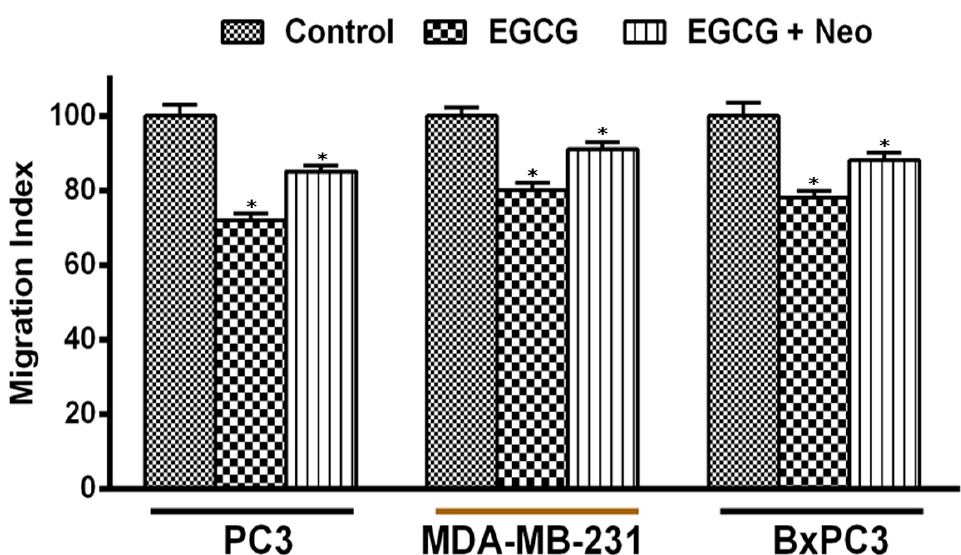
Figure 6. Effect of EGCG on migration of PC3 (prostate), MDA-MB-231 (breast), and BxPC3 (pan- creatic) cancer cells in the presence of copper chelating agent neocuproine. A cell migration assay was performed by using 24-well transwell permeable supports with 8 mm pores (Corning, NY, USA) as described in the Materials and Methods section. The cells were grown in the presence and absence of EGCG (50 µM) with or without neocuprione (50 µM). The fluorescence of the migrated cells was read in an Ultra Multifunctional Microplate Reader (TECAN, Durham, NC, USA). Values reported are ± S.E of three independent experiments. * p value < 0.01 when compared to control.